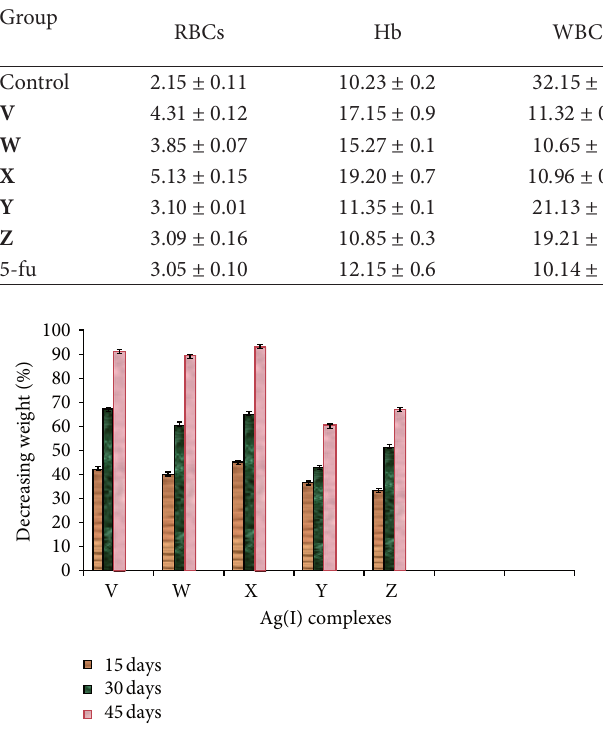
F2:ComparativeeffectsoftreatmentsversusAg(I)complexes on reduction of body weights in tumor-induced